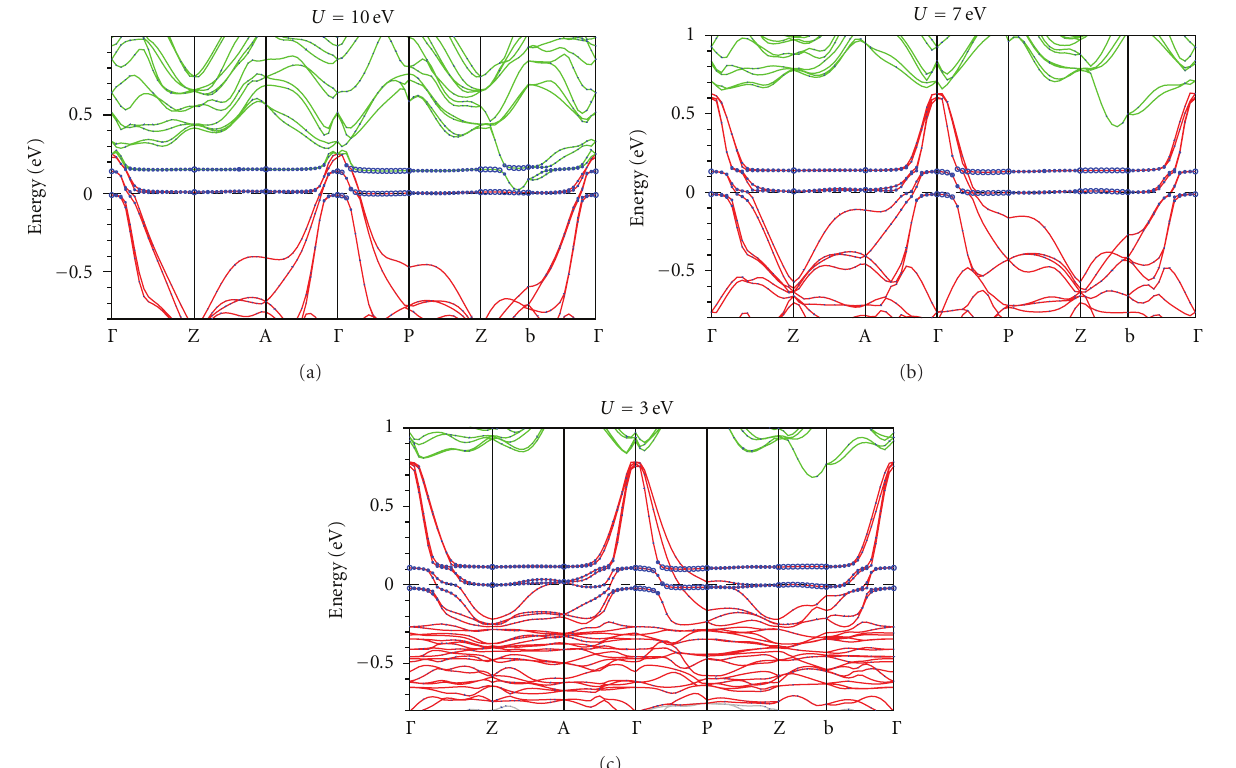
Figure 82: The energy band structure of Sm 4 Bi 3 calculated in LSDA+ U approximation around the Fermi level for various values of U [455].